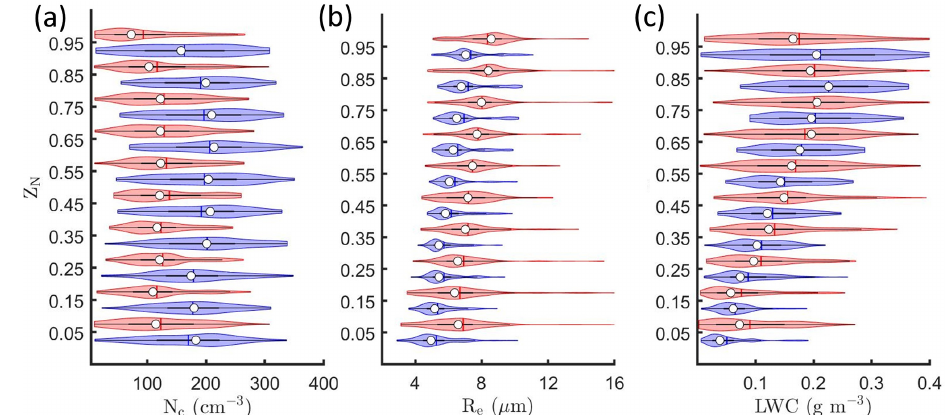
Figure 10. Kernel density estimates (indicated by the width of shaded area) and boxplots showing the 25th (Q1), 50th (white point), and 75th (Q3) percentile for (a) N c , (b) R e , and (c) LWC as a function of Z N for contact (blue) and separated (red) profiles.